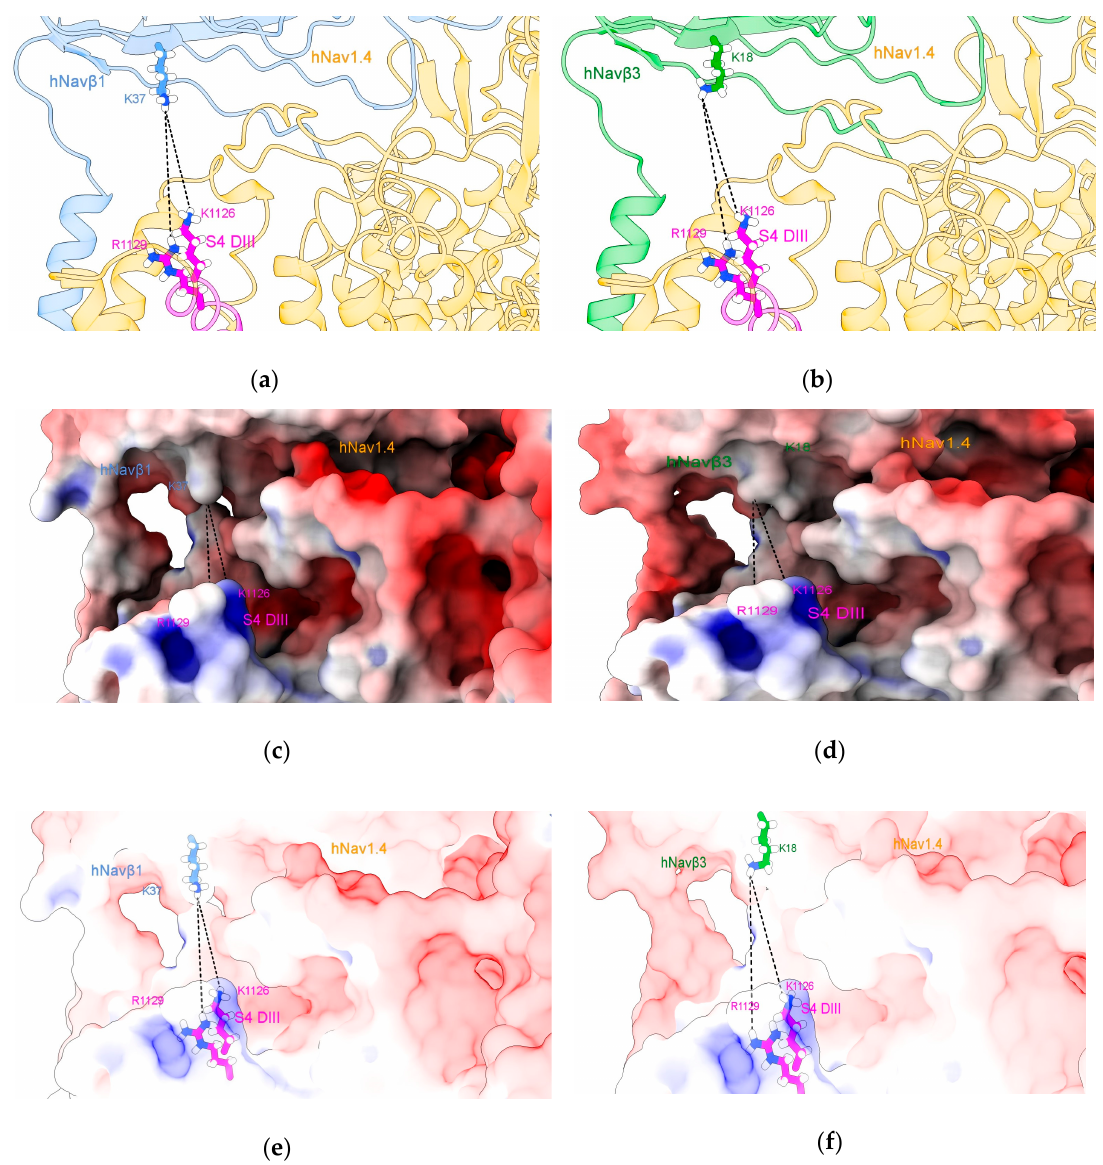
Figure 5. S4 DIII voltage sensor of hNa v 1.4 α [49] in close contact with hNa v β 1 [49] or hNa v β 3 [55]. ( a ) hNa v 1.4 α interfaced with hNa v β 1; ( b ) hNa v 1.4 α interfaced with Na v β 3; ( c , e ) the MEPS at the interface